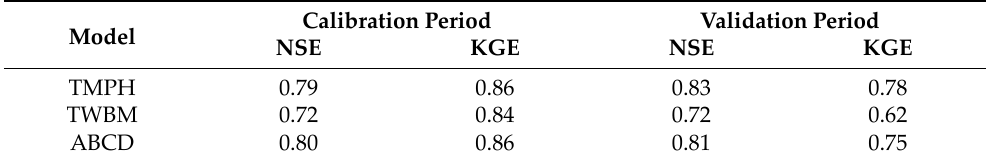
Figure 3. The simulated runoff in the UHRB in the validation period. Table 2. The comparasion results of TMPH, TWBM, and